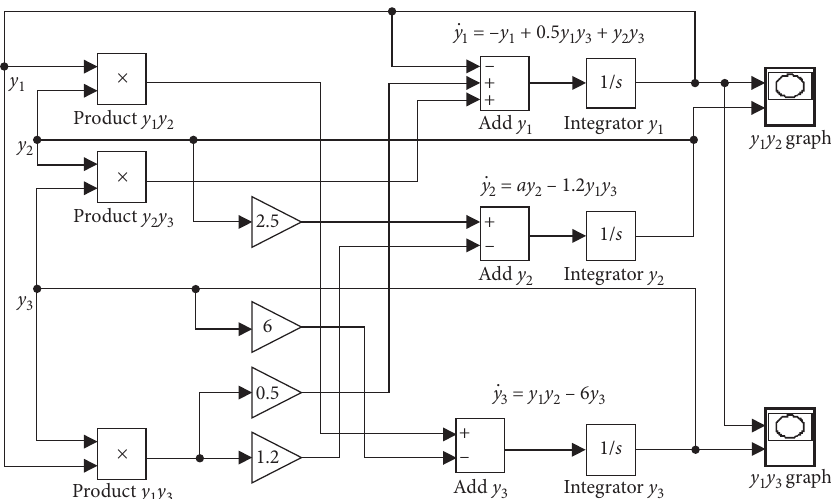
Figure 5: Implementation of response system (2) realized by block diagram in the MATLAB Simulink module.